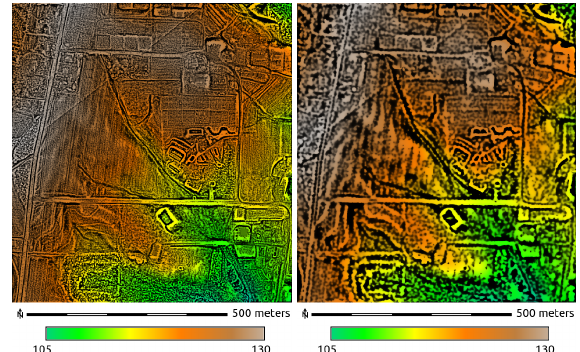
Figure 7: An example of a terrain interpolated from airborne lidar point cloud. The left image shows terrain interpolated from the original point cloud. The right image shows terrain interpolated from the point cloud decimated using count-based decimation with preserving every 10 th point. The colors shows elevation while shading is done using the local relief model.